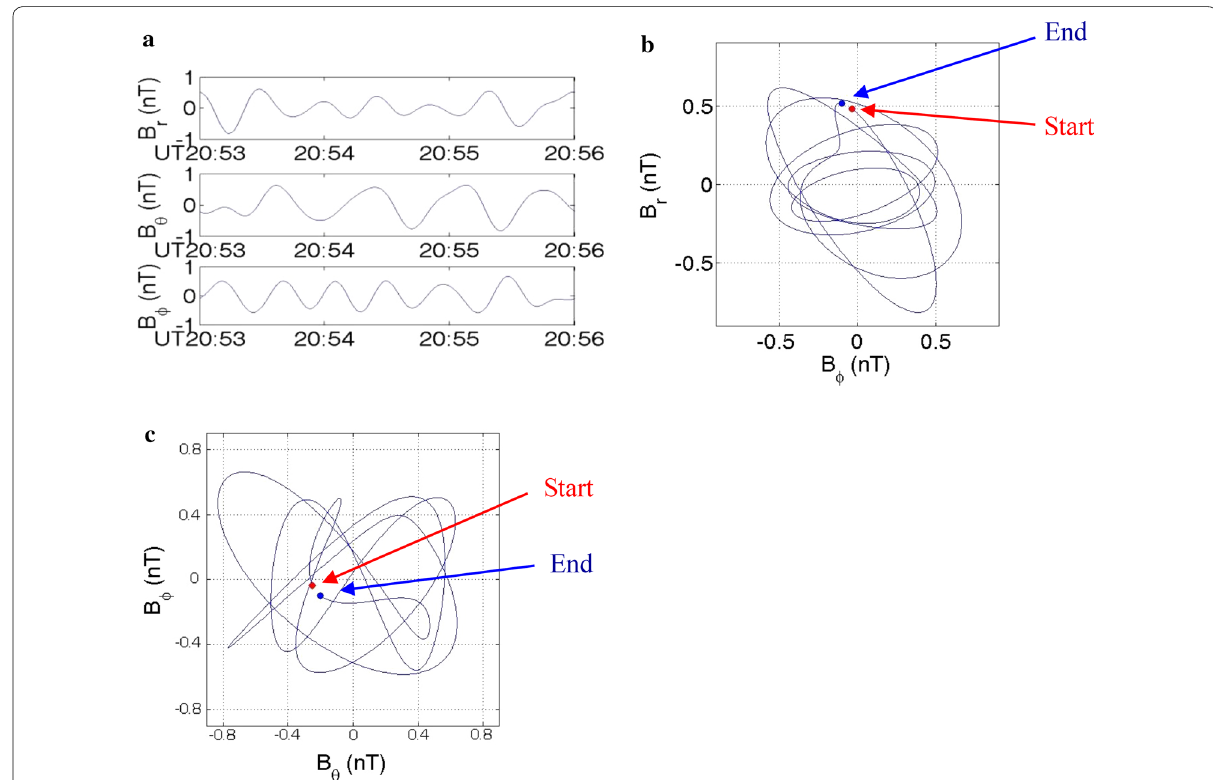
Fig. 5 An event showing the superposition of a transverse ion cyclotron wave and a compressional mirror mode for R outside 6 R S on October 13, 2009. a Perturbed magnetic field components in KRTP coordinates, B 0 ~58 nT, and b left-hand circular polarization in the transverse magnetic components. c The mixture of the parallel compressional mirror mode and the transverse ICW magnetic components. The red point denotes the start time and the blue point denotes the end